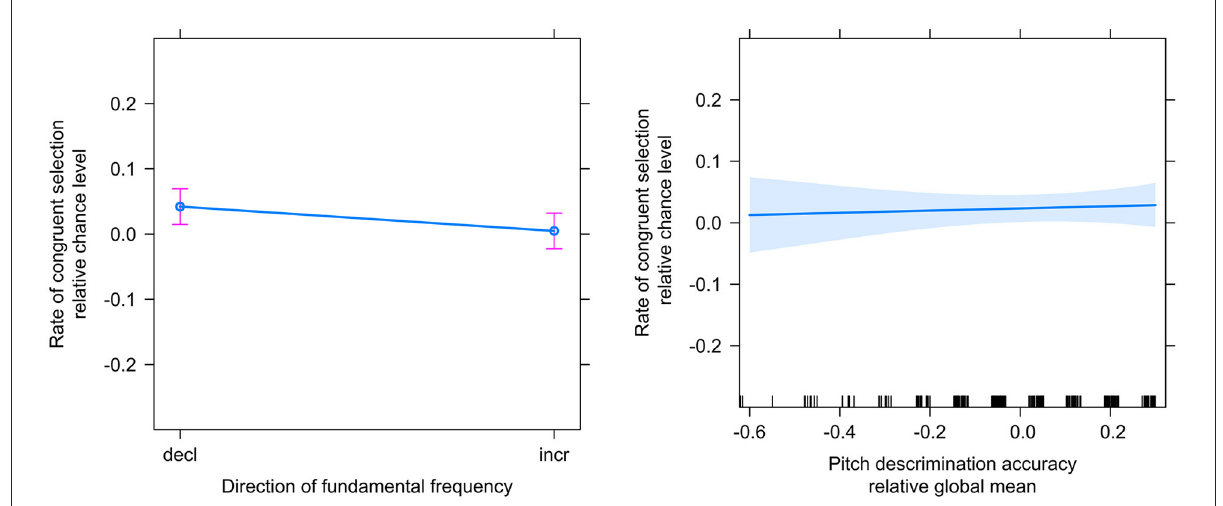
FIGURE2 Estimated means and 95% confidence intervals of selection congruency related to factors f 0 direction (left) and pitch discrimination accuracy (right) from analysis of the follow-up experiment.